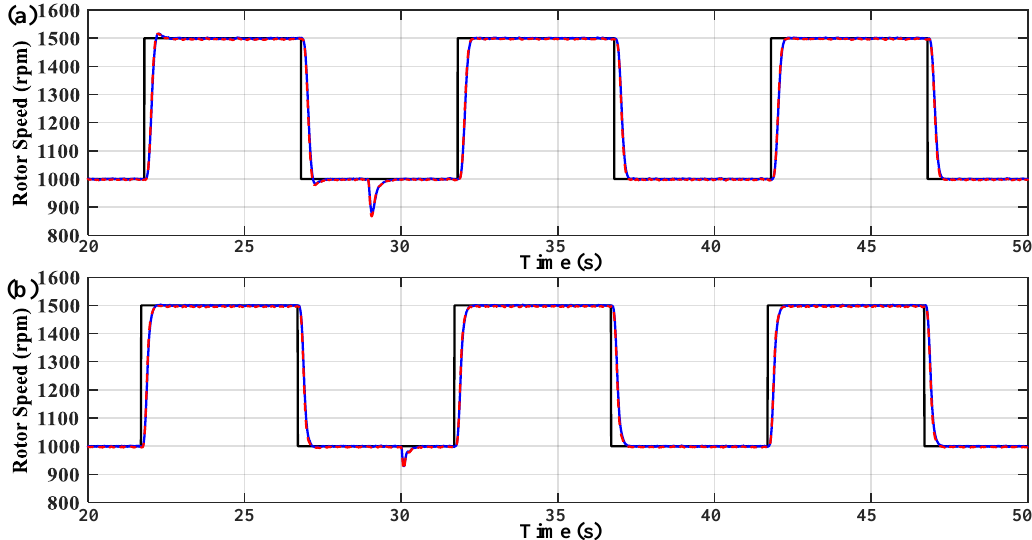
Figure 22. Comparison of speed response of experimental results in the case of the varied external load for R L = 100 → 50 Ω: ( a ) PI controller; and ( b ) NFC controller.